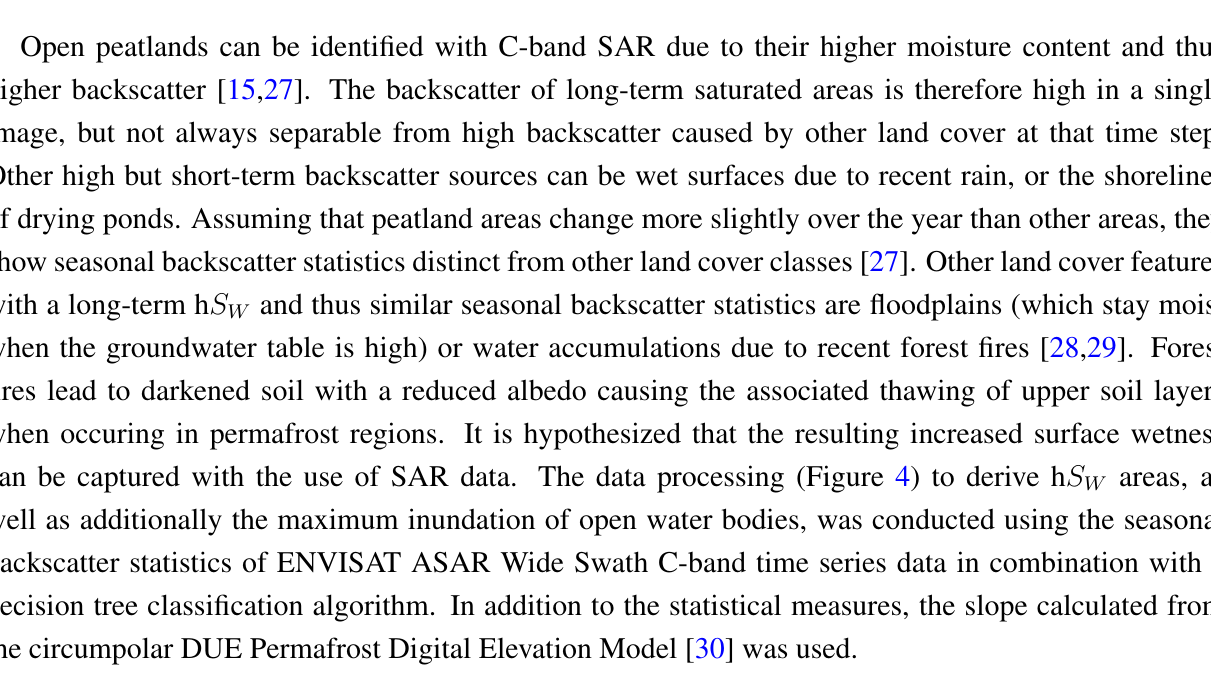
Figure 4. Schematic representation of the classification method to derive h S